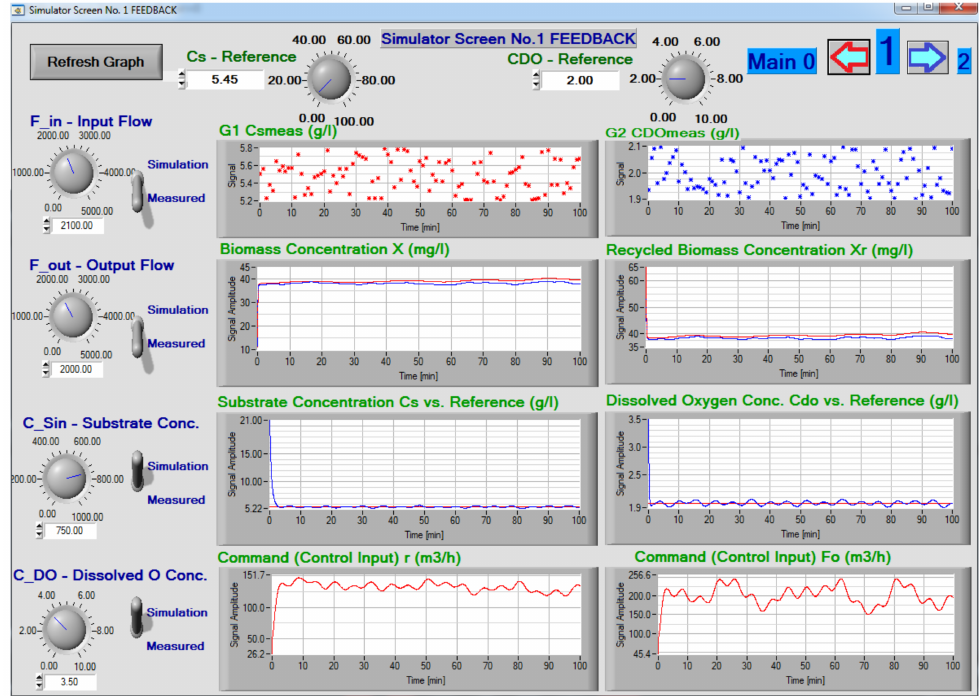
Figure 9. A sample from the source code used for the implementation of the multivariable adaptive control structure of the ASP within the WWTP.